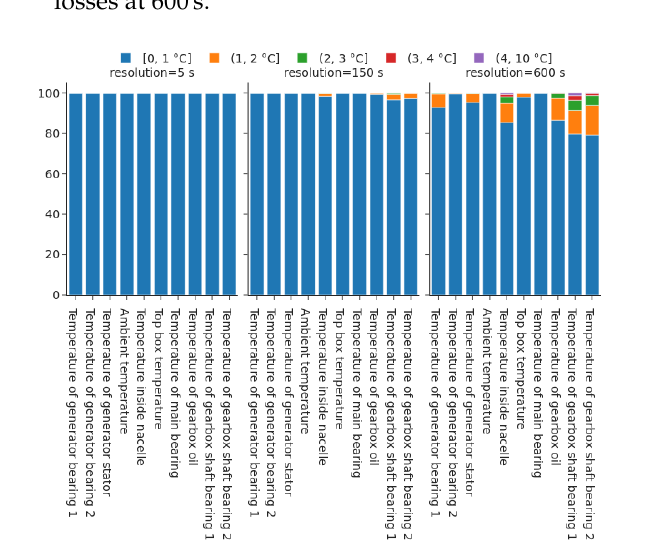
Figure 6. Information loss of three exemplary temperature signals for selected aggregation resolutions. Error bins are temperature intervals measured in degrees Celsius.